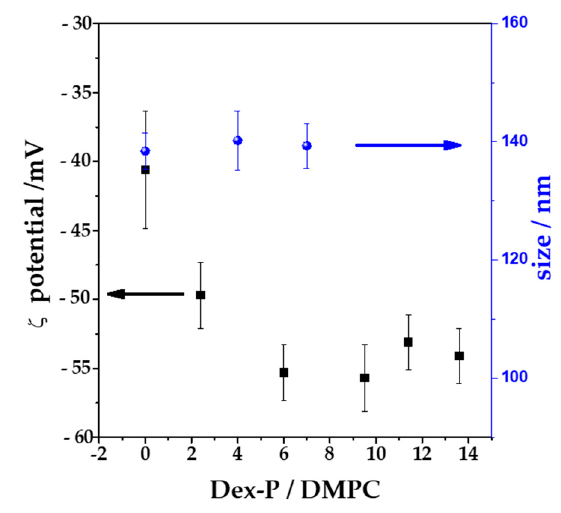
Figure 6. ζ potential (mV) and LUVs size as function of the Dex-P/DMPC ratio. Experimental conditions: 1 mM NaCl, T = 25 °C.